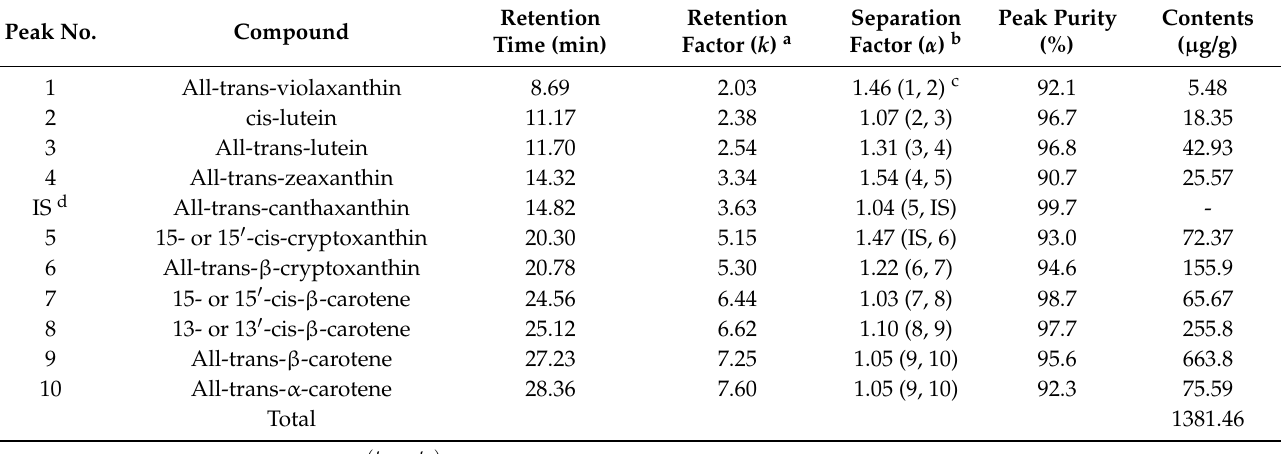
Table 1. Retention time, retention factor ( k ), separation factor ( α ), purity and content ( µ g/g) of carotenoids in sweet potato